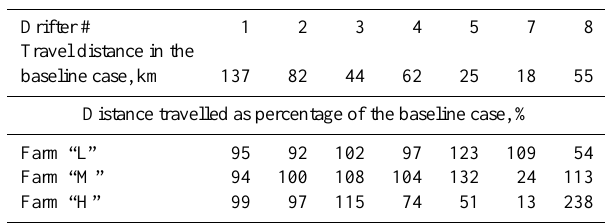
Distance travelled as percentage of the baseline case, %